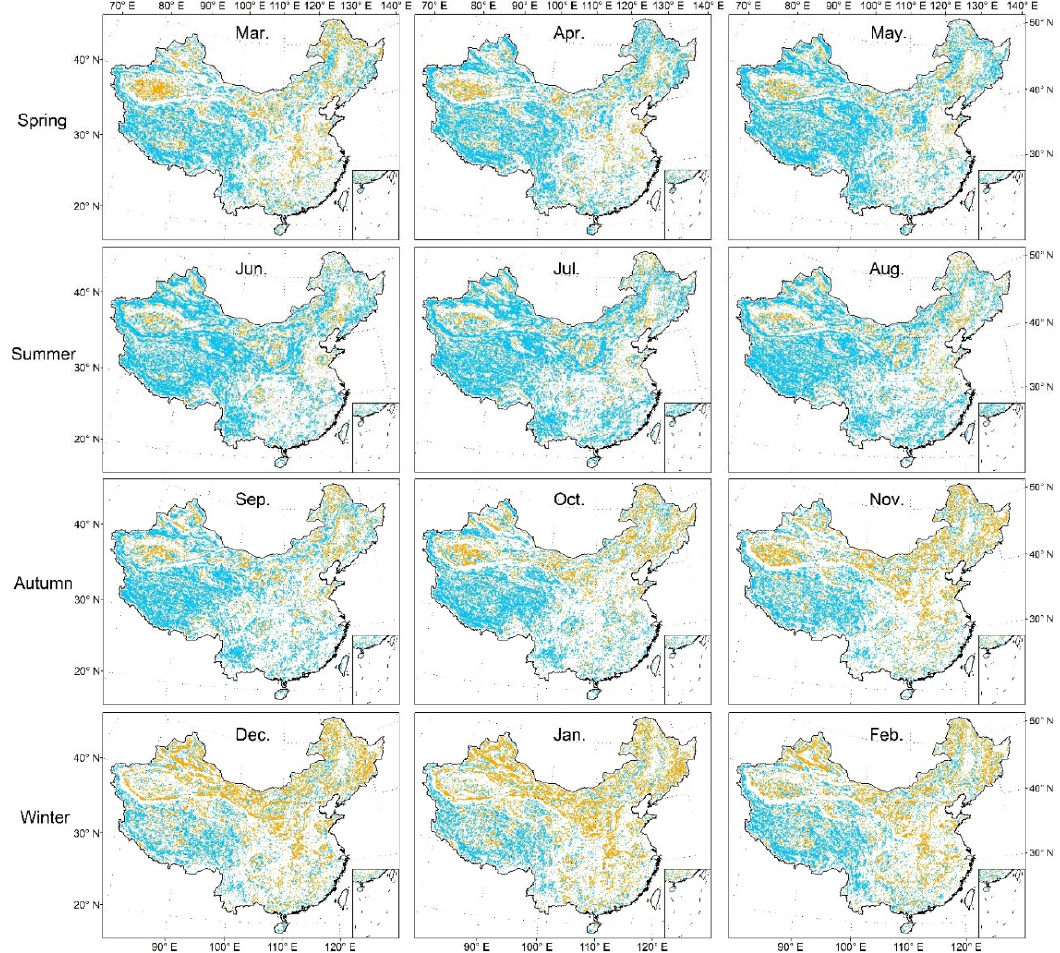
Figure 4. As Figure 3 but of the monthly average TLR. The blue and orange color indicate the image pixels with - 15 < Γ ≤ - 7 and 0 < Γ ≤ 10 °C/km, respectively. The white color indicates the other TLR values.